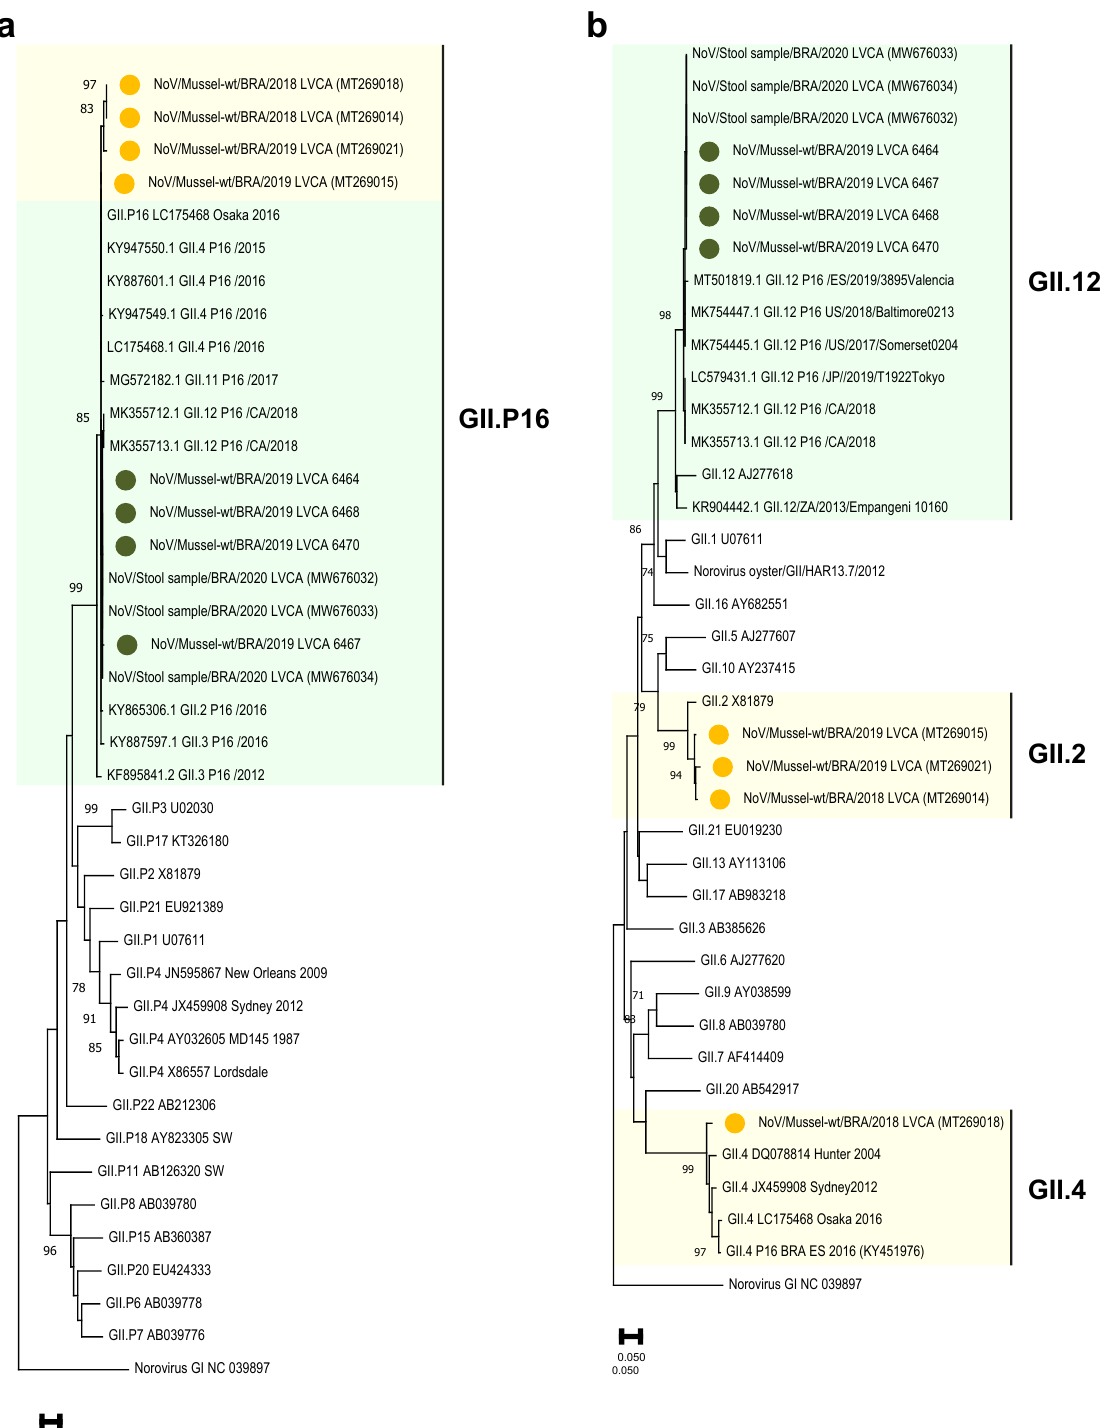
Figure 3. Phylogenetic trees based on ( a ) polymerase and ( b ) capsid regions of GII norovirus. Norovirus GII strains ( n = 4) isolated from bivalve samples in this study are denoted with a green- filled circle, while GII strains obtained in initial results ( n = 4) published by Sarmento et al. [17] are marked with a yellow-filled circle. Reference strains were downloaded from the GenBank repository and labelled with their genotype and accession number. Maximum likelihood phylogenetic trees were constructed with MEGA X software with bootstrap tests of 2000 replicates, based on the Kimura two-parameter model. The bootstrap percentage values of ≥ 65% are shown at each branch